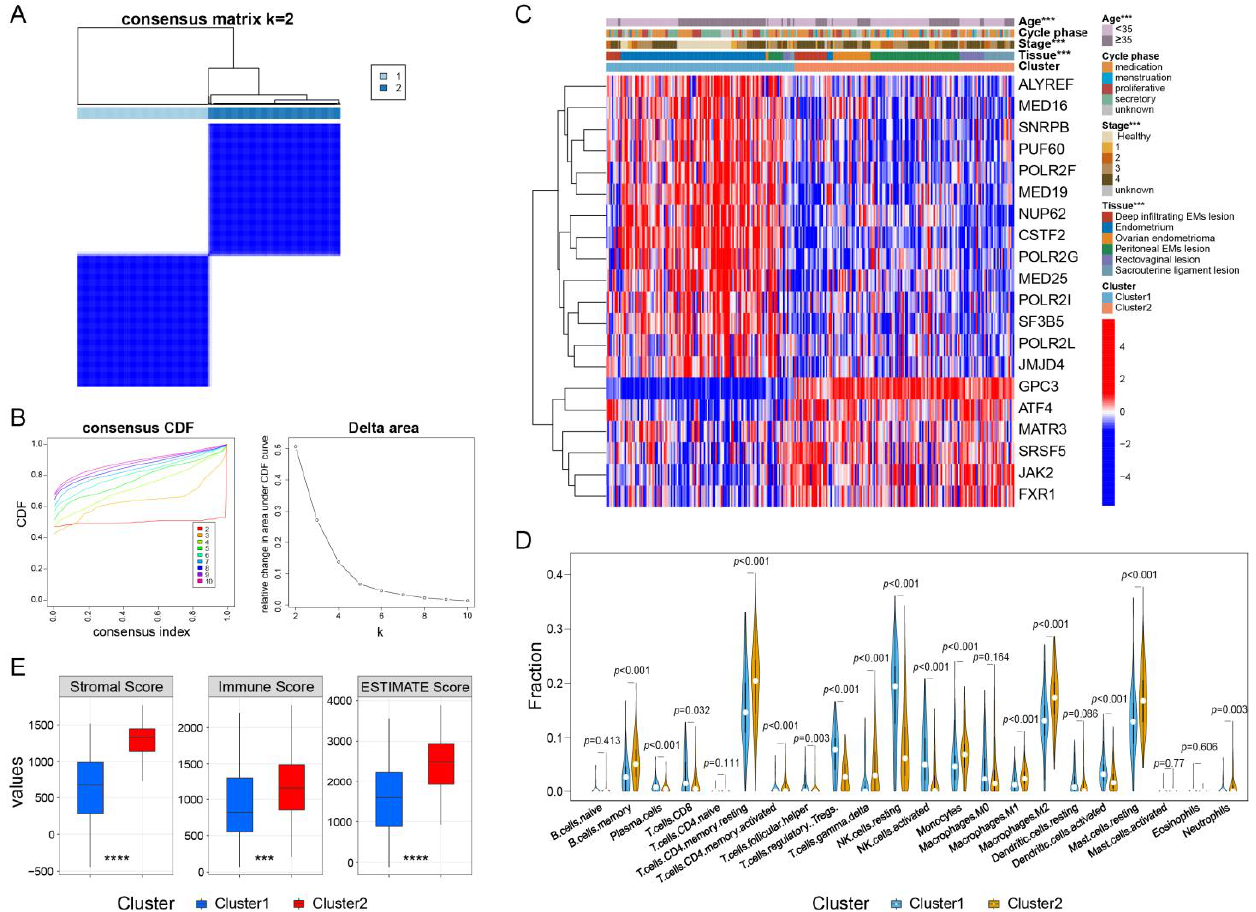
Figure 4. Heterogeneity patterns and immune characteristics of m6A-related mRNAs in EMs. ( A , B ) According to the clustergram and delta area plot, the best clustering number was set up to 2. ( C ) Differences in clinicopathologic features and the expression levels of m6A-related mRNAs between the two distinct clusters. ( D ) The infiltration levels of 22 immune cells in the two clusters. ( E ) Different scores (stromal score, immune score, and estimate score) distinguished the configuration and function evidently from clusters. ***, p < 0.001, ****, p < 0.0001.